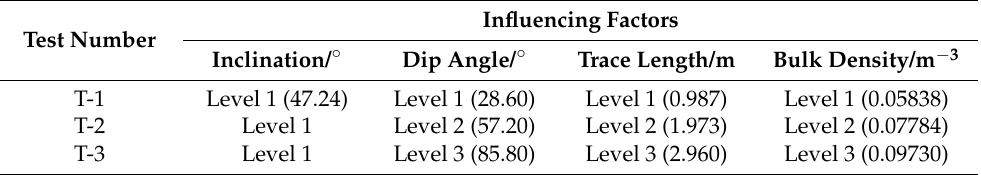
Table 3. Orthogonal arrays L 9